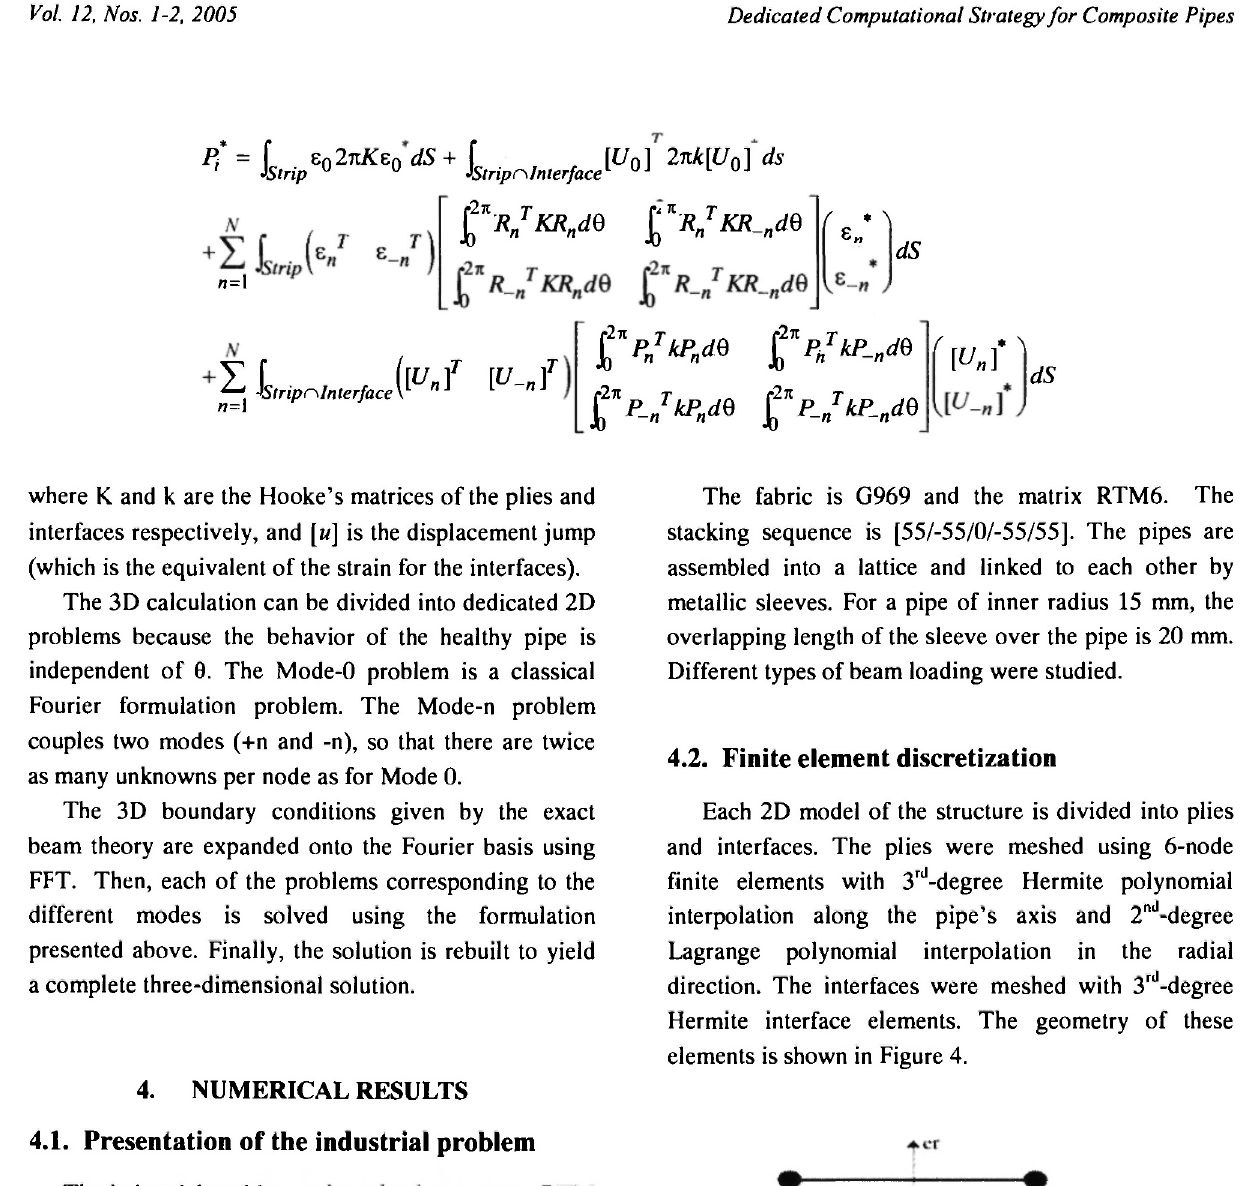
Fig. 4: Description of the elements The number of degrees of freedom depends on the mode being considered. For Mode 0, there are 6 degrees of freedom (DOFs) per node (3 displacements and their z-derivatives). For the other modes, there are 12 DOFs per node (6 for Mode -n and 6 for Mode